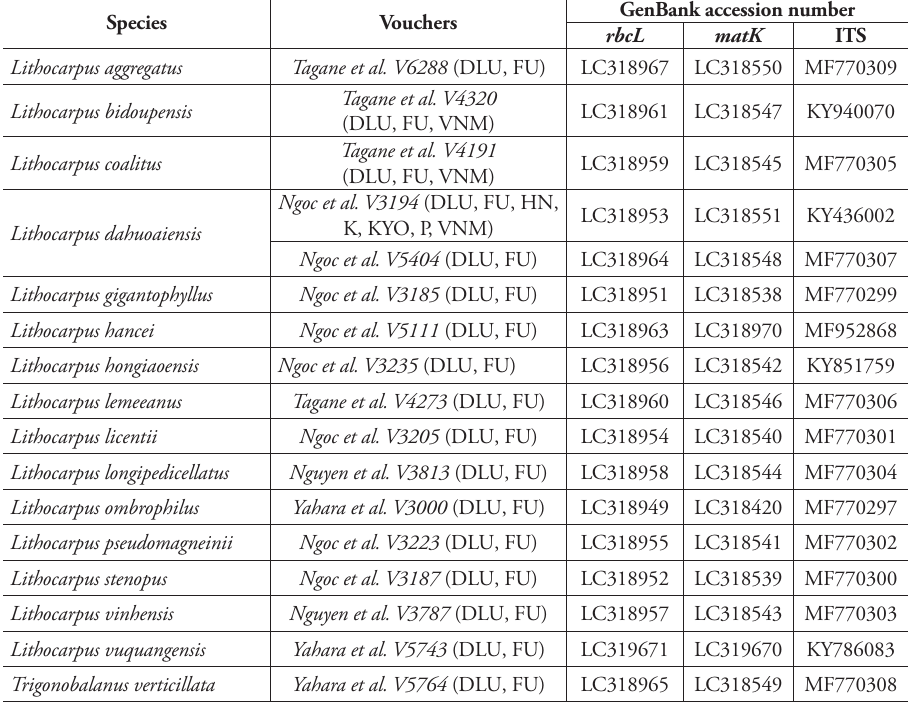
Table 1. List of taxa used in this study with vouchers and GenBank accession